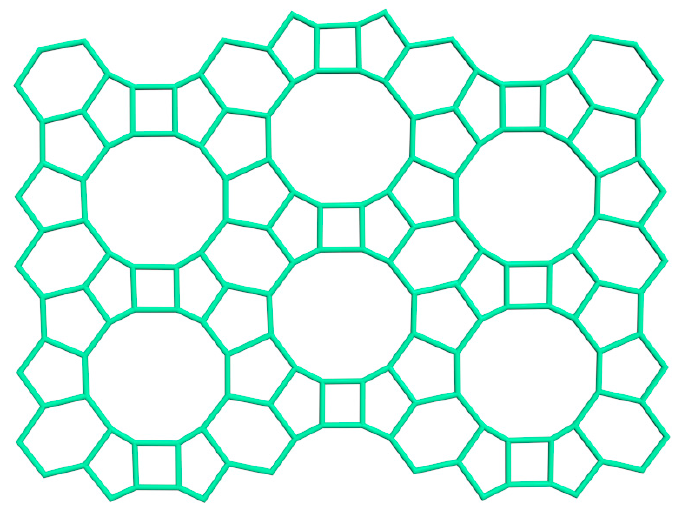
Figure 14. The structure of the zeolite type BETA [compiled by the authors]. It is obvious that, with the partial removal of silicon or aluminum atoms, the diameter of the sphere will